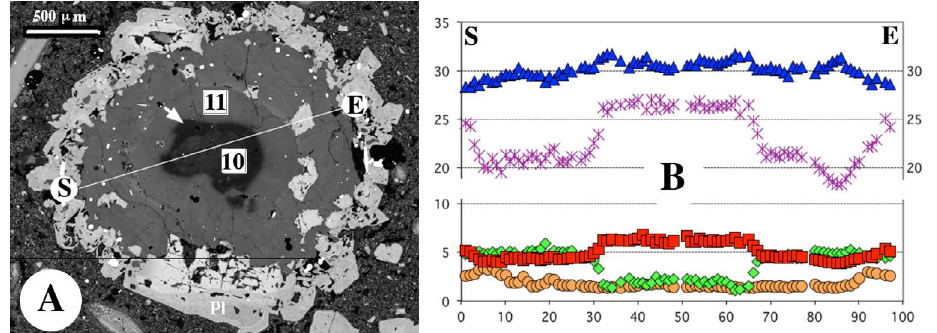
Figure 9: Details about the composite garnet shown in Figure 3E. [A] Ca X-ray image showing the metamorphic CaO-poor core (dark grey) and its Ca-richer magmatic overgrowth (pale grey). The garnet is surrounded by a large granular reaction-rim almost exclusively composed of plagioclase (white). Note the idiomorphic character of plagioclase in contact with the groundmass. Numbers in white boxes refer to garnet analyses in Table 6. [B] The compositional profile shows the strong depletion in CaO and the corresponding enrichment in MgO of the metamorphic core relative to the magmatic overgrowth. Symbols as in Figure